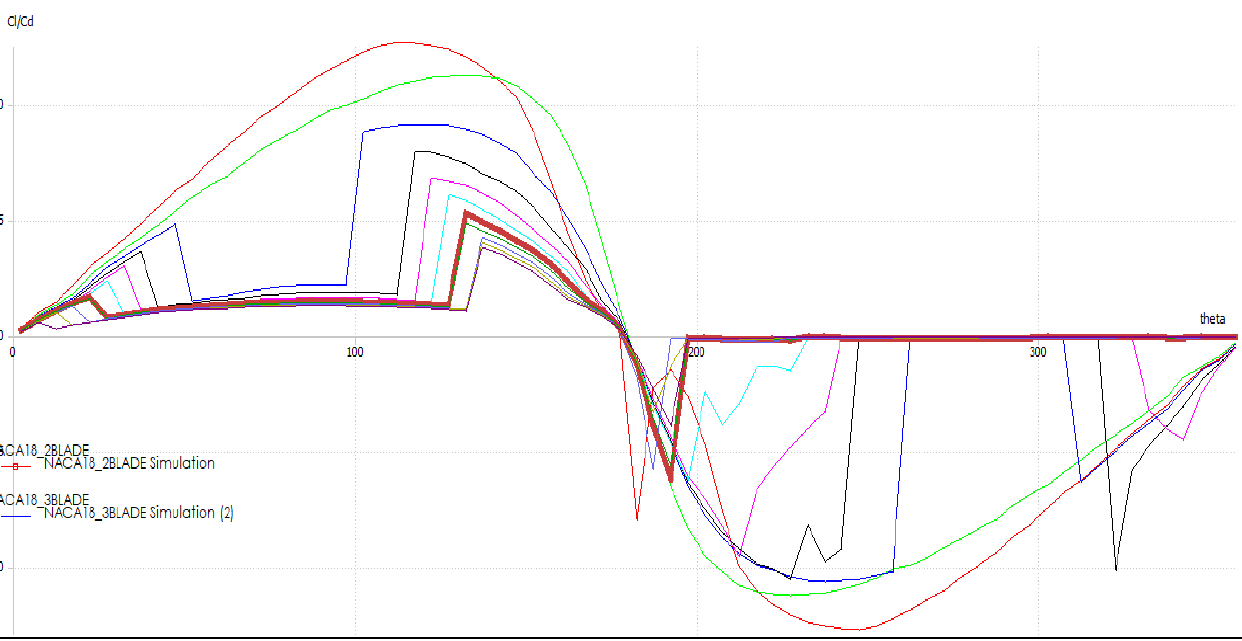
Figure 34. Cl/Cd vs theta plot of bottom-section for TSR